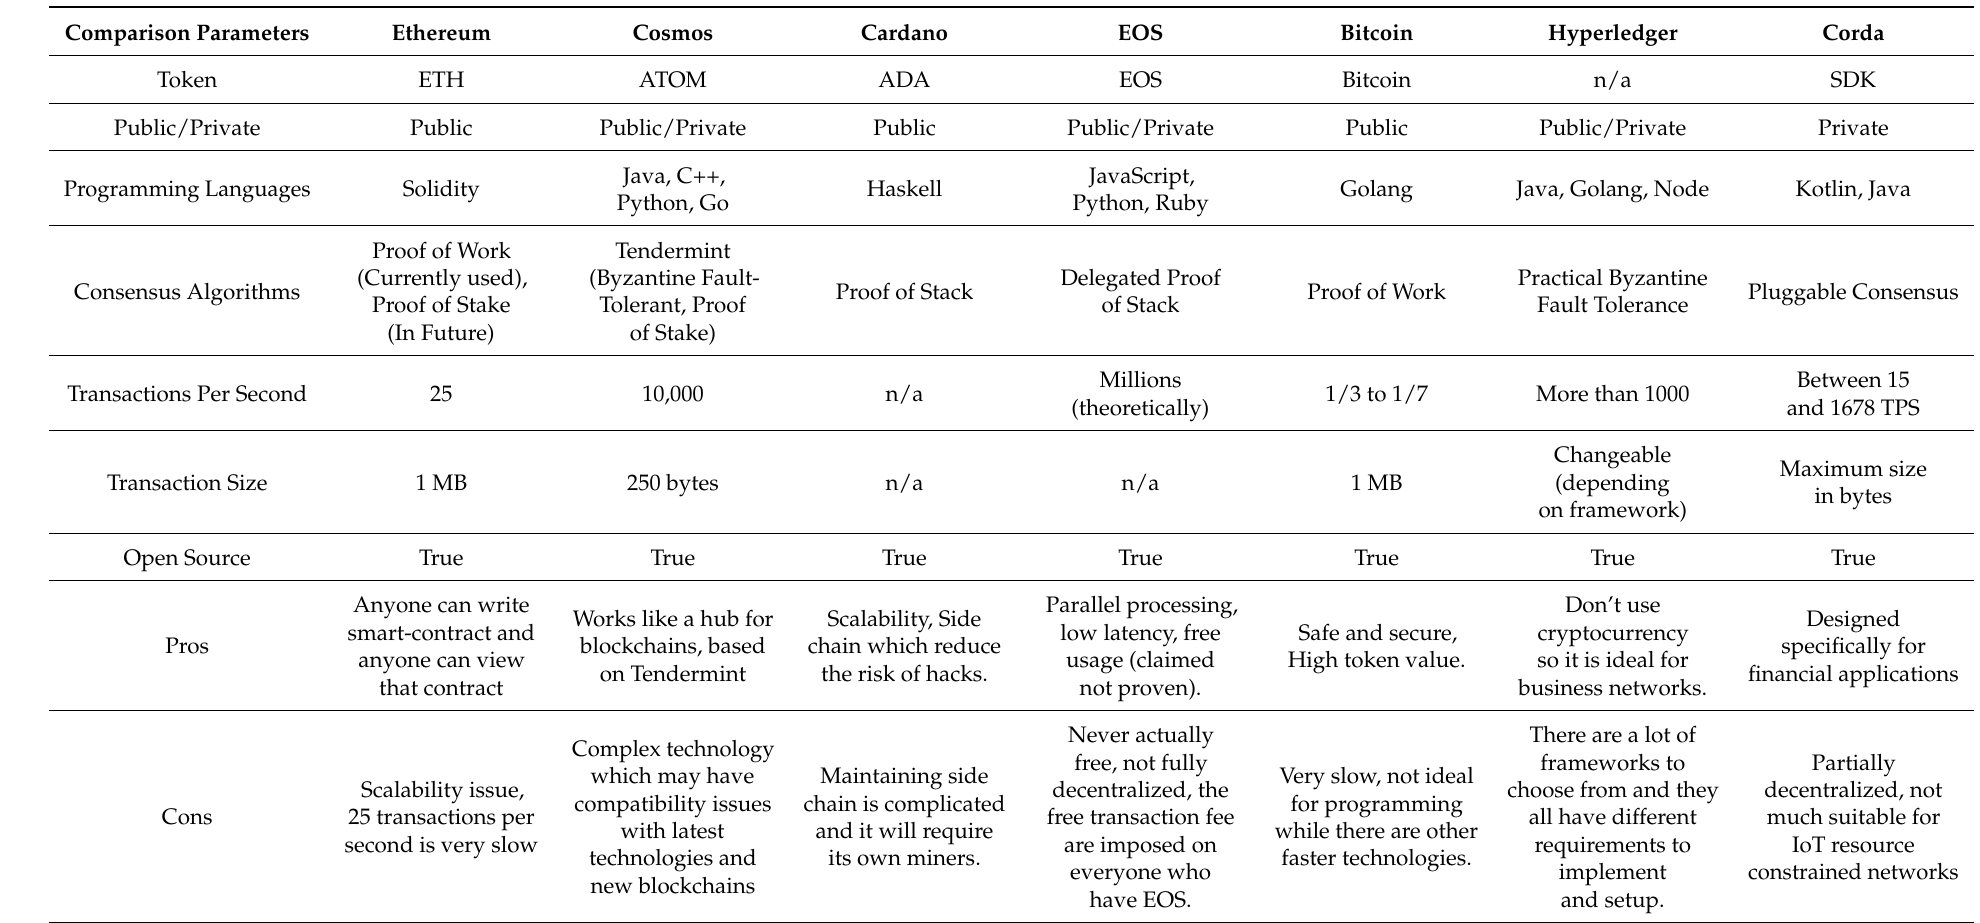
Table 5. Comparison of blockchain